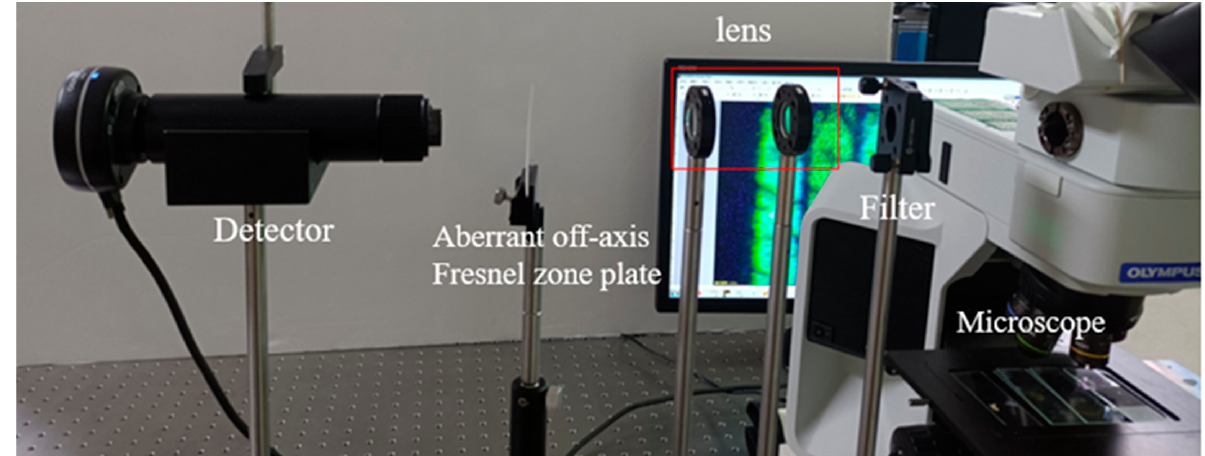
Figure 14. Experimental optical path diagram of chromatography microscope system.